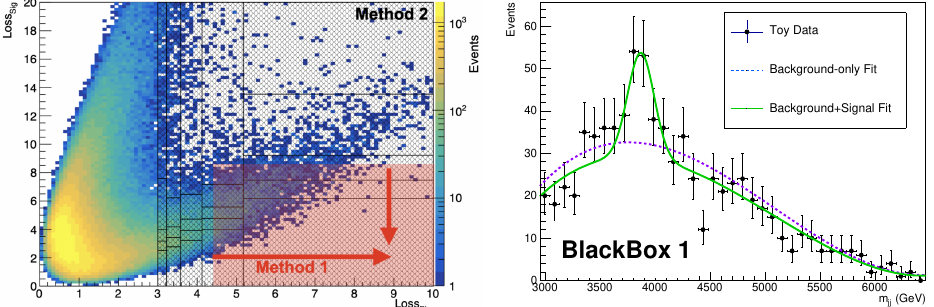
Figure 6 . (Left) Illustration of the two methods used for the signal extraction. In Method 1, shown in red, we iteratively vary a selection on the signal loss L sig and background loss L bkg and select regions of low signal loss and high background loss. In Method 2, we separate the events by the black shaded boxes shown corresponding roughly to a uniform populations of events within each shaded region. (Right) Dijet mass fit after performing an optimized selection of L sig < 8 and L bkg > 5 . 5 , a 3rd order Bernstein polynomial is used for the background while a Gaussian with a fixed width σ/m jj = 0 . 03 is used for the signal